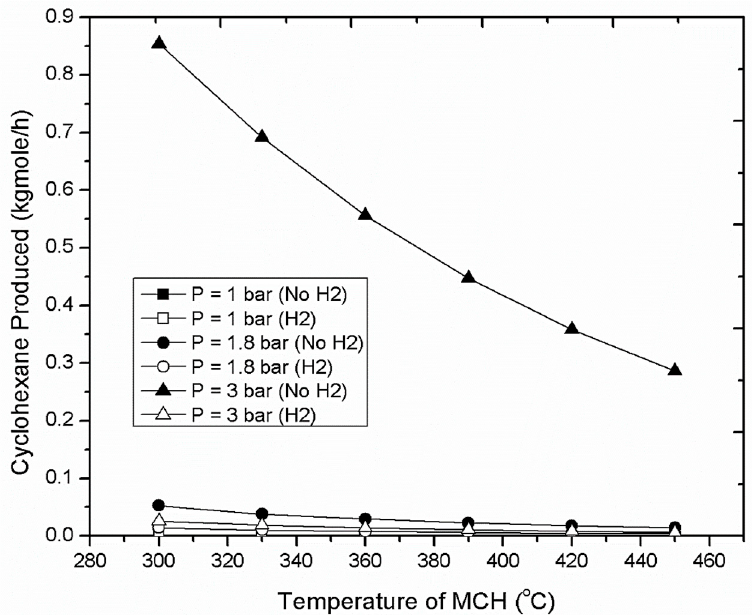
Figure 7. Effect of change in feed operating conditions on the cyclohexane flow rate. Figure 7. E ff ect of change in feed operating conditions on the cyclohexane flow